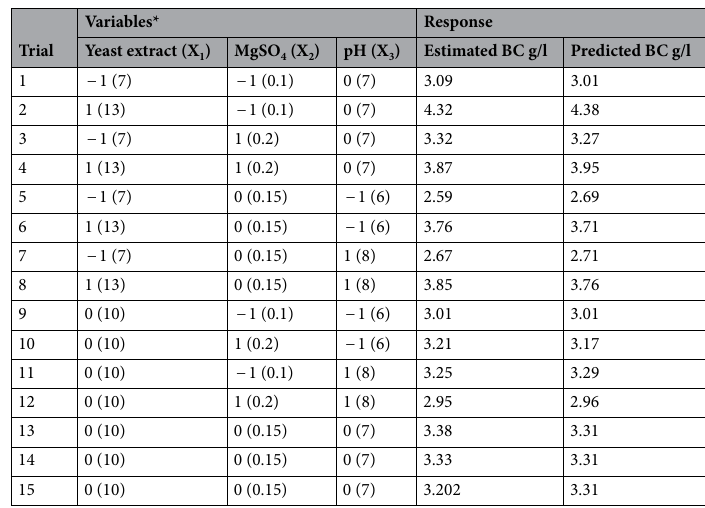
Table 3. BBD for selected four variables with coded and real values, observed and predicted results for BC production. Variables*: X 1 –X 3 (selected variable to optimize their levels); the coded low, middle, and high levels are presented as − 1, 0, and 1, respectively. Variable levels are presented between brackets expressed as g/l for X 1 and X 2 and specific point for X 3 .